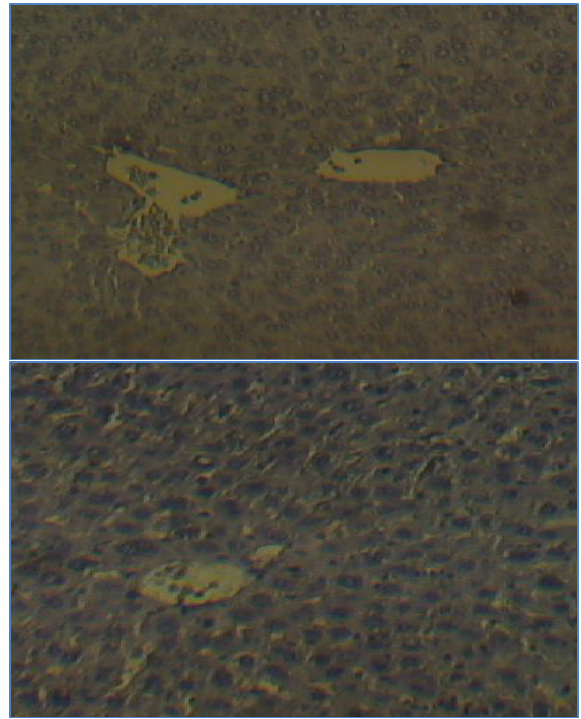
Figure, 3: Left: Liver of DMH+Amg group , Right liver of DMH+M.W group. (Normal)